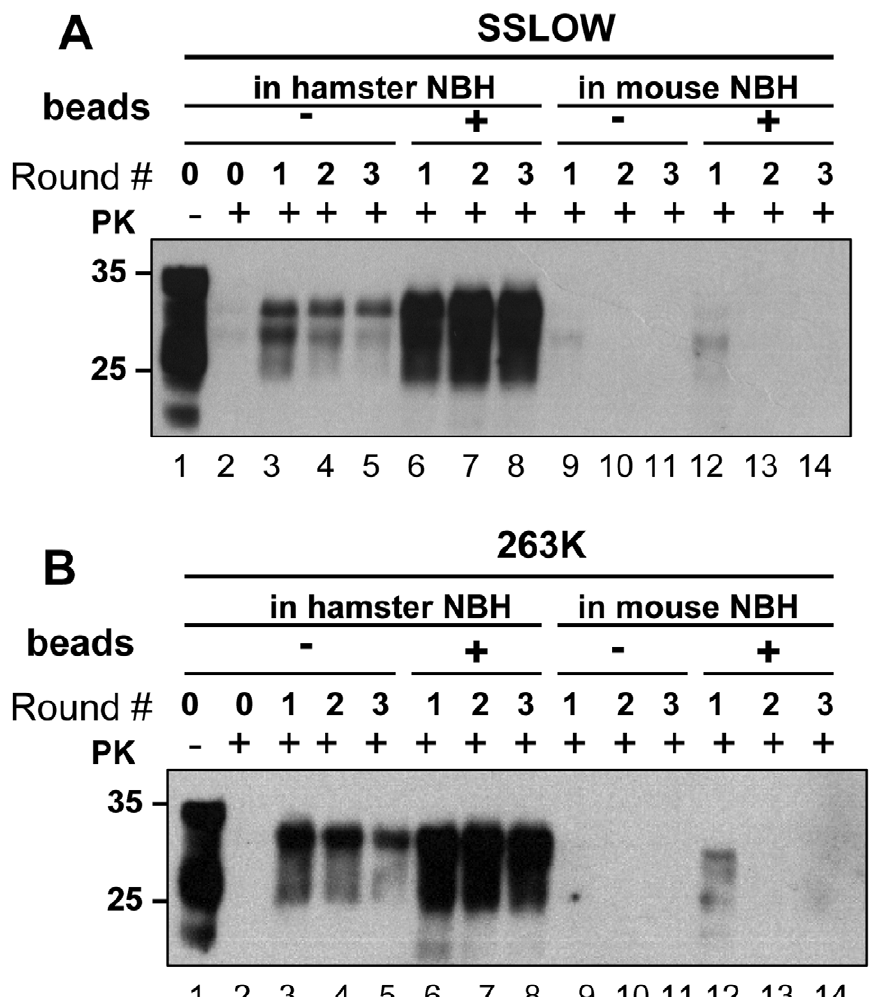
Figure 7. PMCA with beads preserves species barrier. ( A ) SSLOW scrapie brain material was diluted 10 3 -fold into 10% hamster or 10% mouse NBH, subjected to serial PMCA in the absence or presence of 3 large beads, as indicated, and digested with PK. Undigested 10% NBH (lane 1) is provided as a reference. ( B ) 263K scrapie brain material was diluted 10 3 -fold into 10% hamster or 10% mouse NBH, subjected to serial PMCA in the absence or presence of 3 large beads, as indicated, and digested with PK. Undigested 10% NBH (lane 1) is provided as a reference. Each PMCA round consisted of 48 cycles; the material amplified in each round was diluted 10-fold into 10% NBH for the next PMCA round.